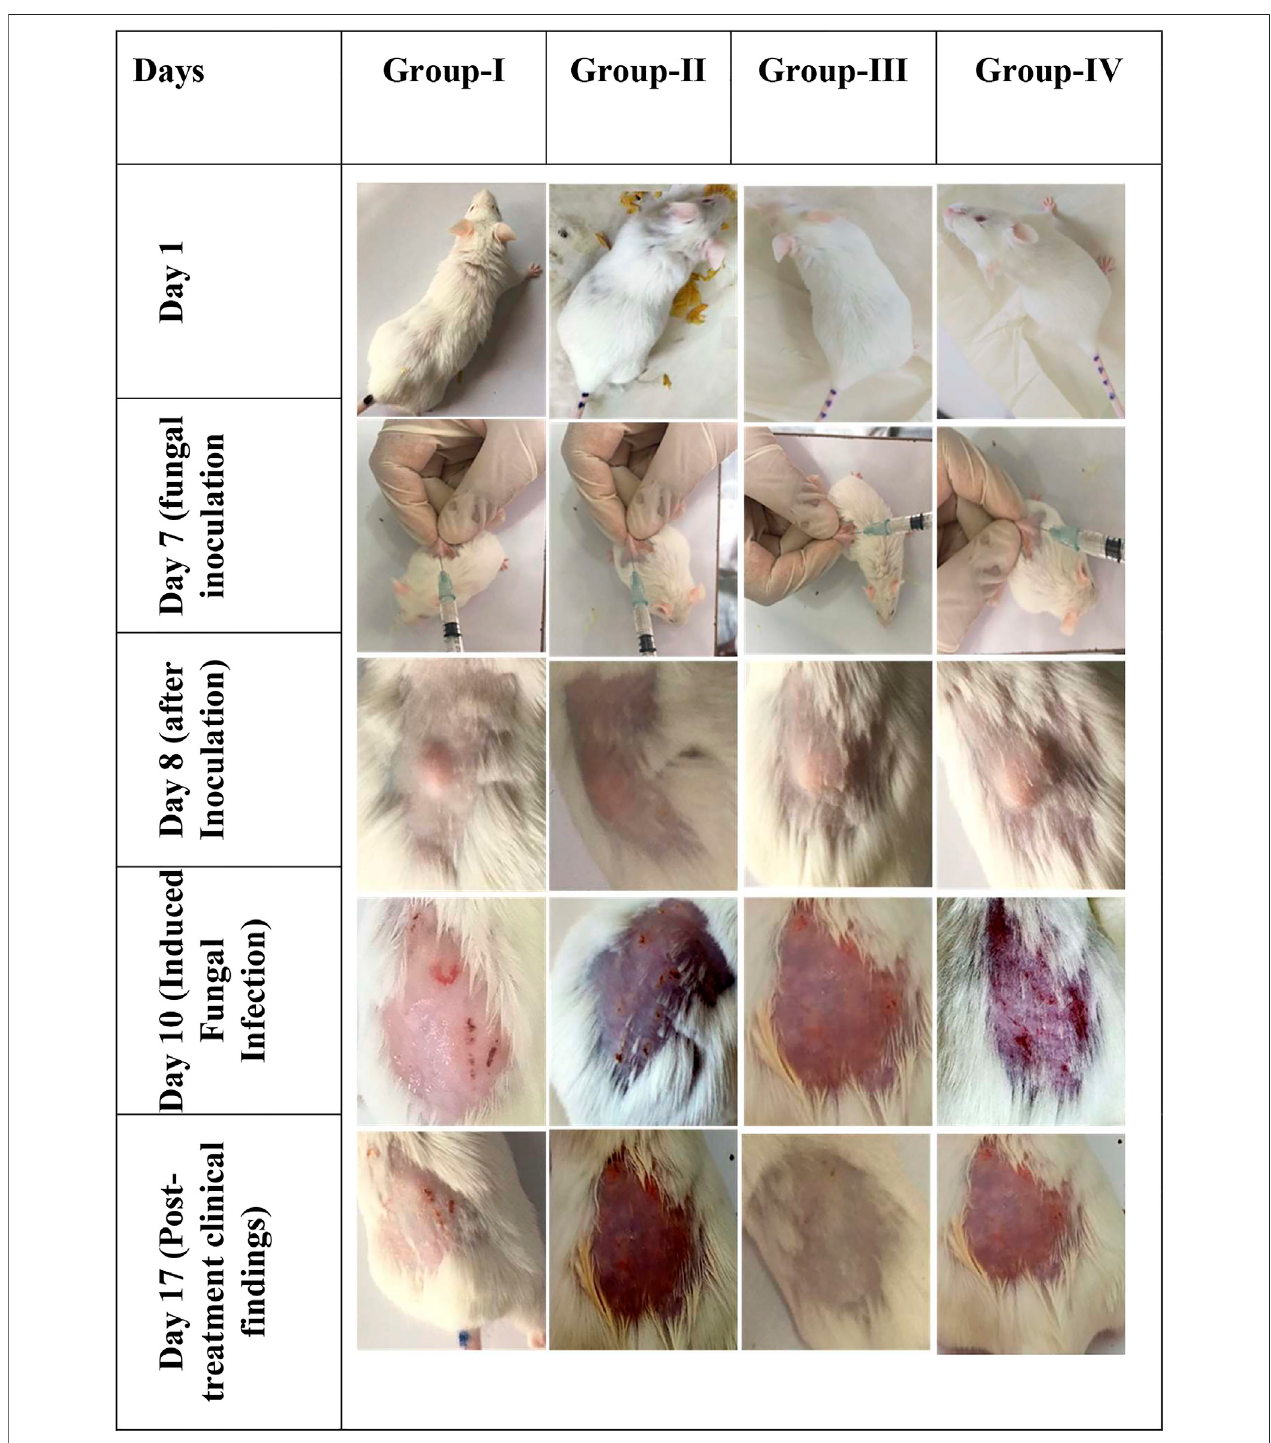
FIGURE 4 | In vivo images of male Wister albino rats. Gel preparations were applied on the dorsal skin surface and observed for clinical fi ndings ( n = 6).